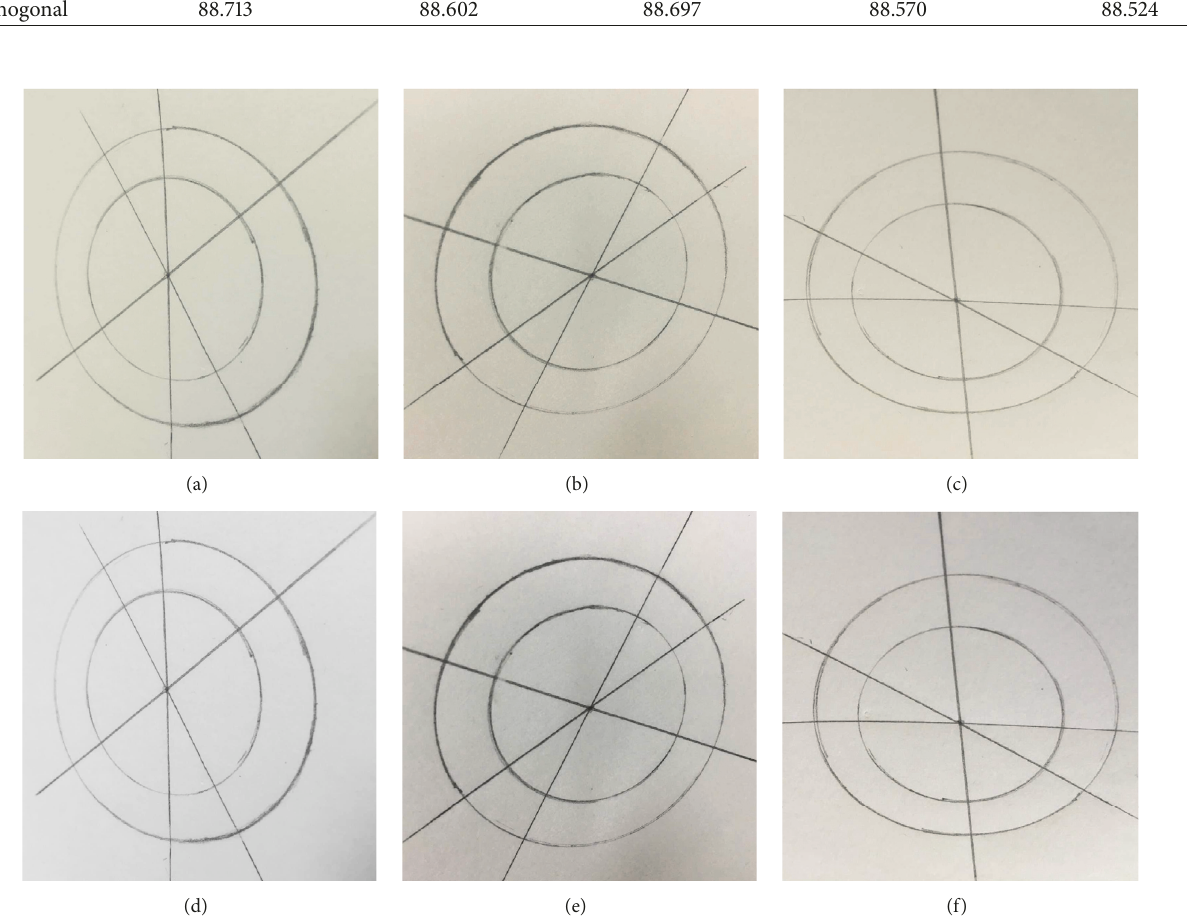
Figure 4: Images of the template containing two concentric circles and three lines passing through their centre in the real experiment: (a)–(c) the original images taken by a camera, (d)–(f) the corrected images.